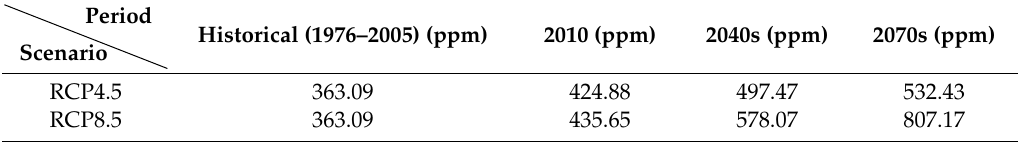
Table 2. The CO 2 data was obtained from the input database of the FAO-AquaCrop 5.0 model.